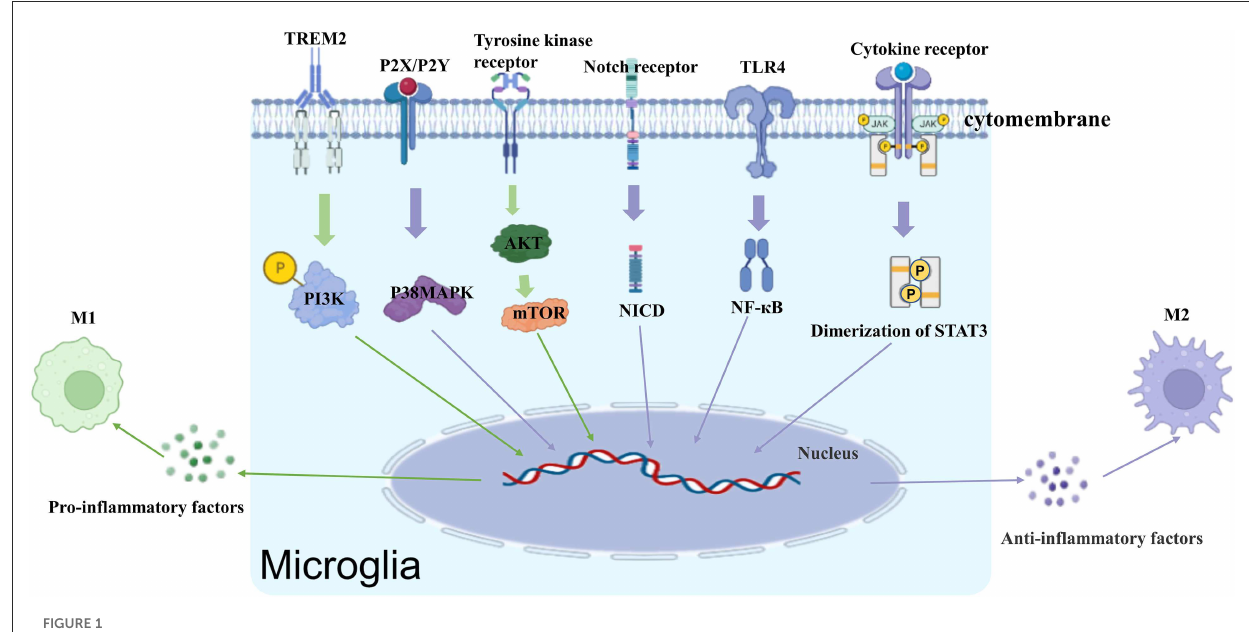
FIGURE1 Receptors and signaling pathways that regulate microglia